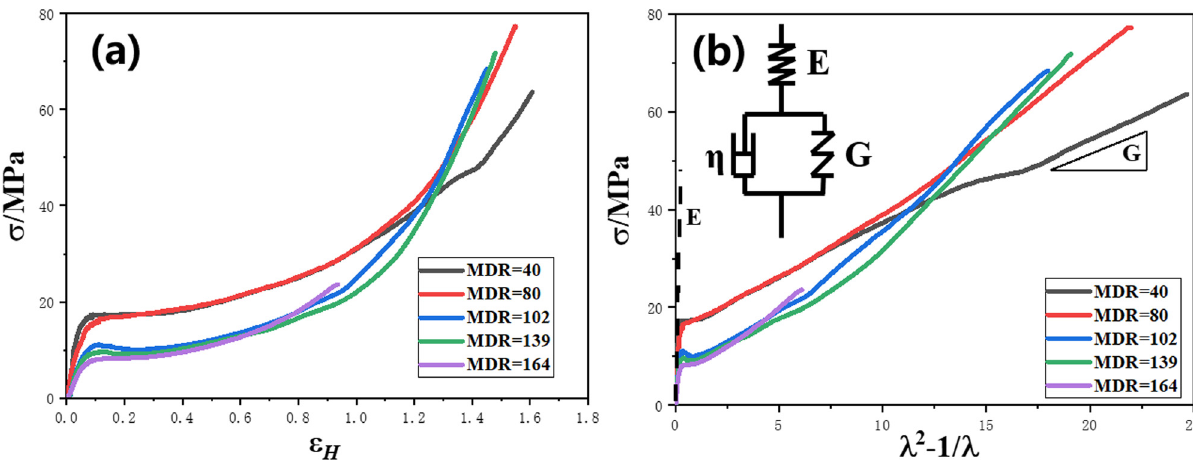
Figure 5: True stress – strain curves of PMP fi lms with di ff erent MDRs at 60°C ( a ) and the corresponding Haward – Thackray plots ( b ) . The model is shown as an inset in ( b ) .